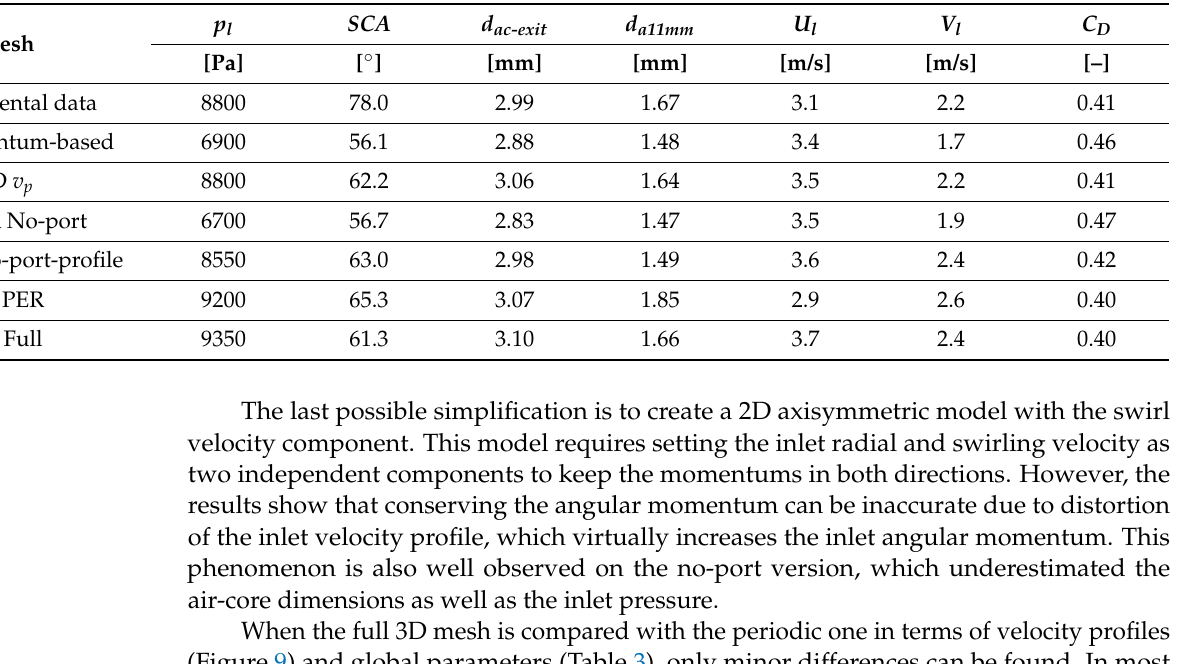
Table 3. Comparison of model geometry. Re = 2000, laminar model,